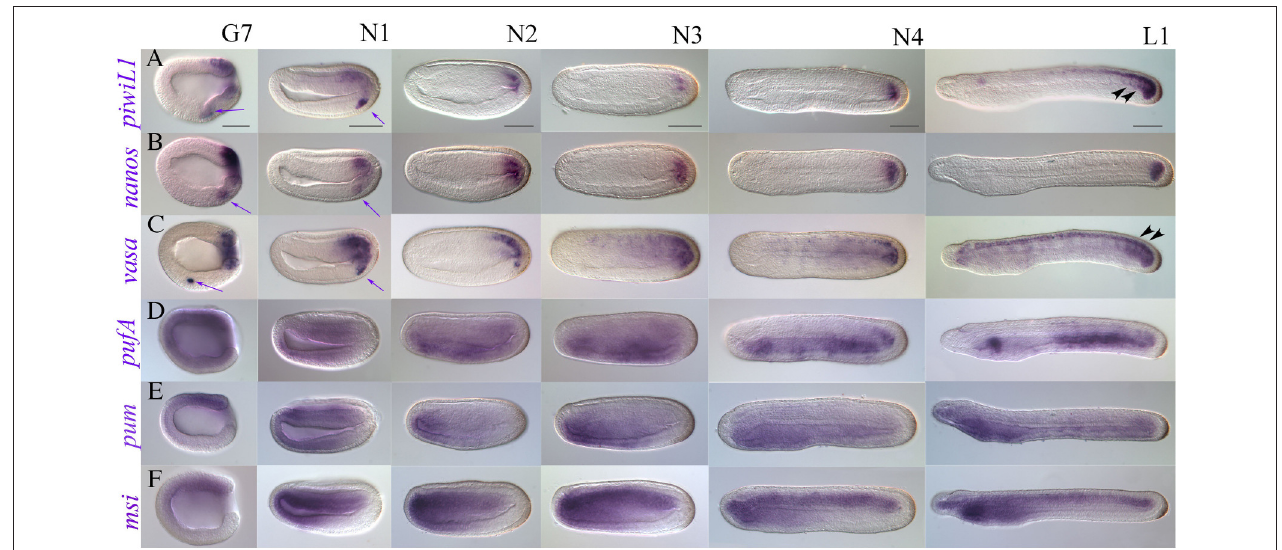
FIGURE 5 | Late expression of a representative subset of putative somatic stem cell and germline makers in B. lanceolatum (lateral views). (A) piwi-like1; (B) nanos ; (C) vasa ; (D) pufA ; (E) pumilio ; (F) musashi . Embryonic stages are indicated along the top of panel (A) , from late gastrula/early neurula G7 to the premouth larval stage L1. Purple arrows indicate PGC-like expression that continues to be detectable for piwi-like1 , nanos , and vasa into the early neurula stage N1. Black arrowheads in (A) and (C) indicate expression demarcating somite boundaries. All views are lateral, and all panels are oriented with anterior to the left and dorsal up. Scale bars = 50